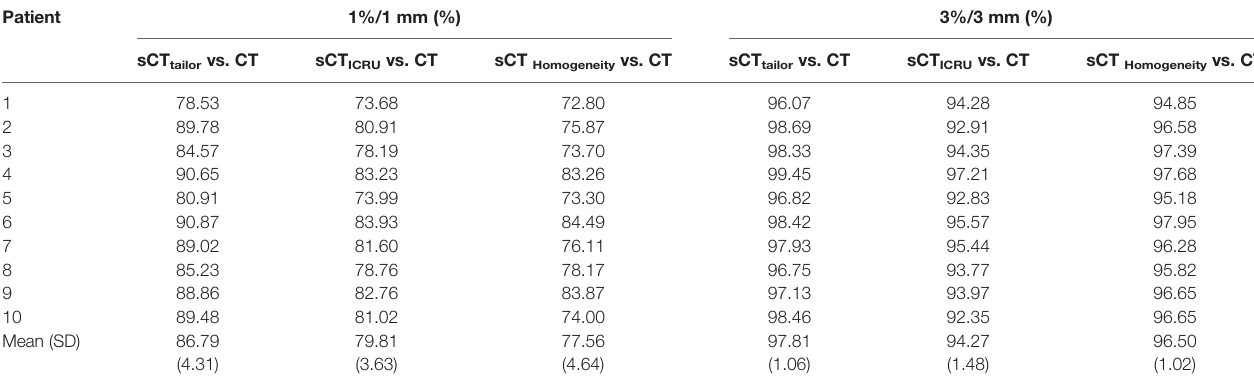
TABLE 3 | Gamma passing rate comparison for 10 patient plans on sCT tailor , sCT ICRU , and sCT Homogeneity (1%/1 mm, 3%/3 mm). Patient 1%/1 mm (%) 3%/3 mm (%) sCT tailor vs. CT sCT ICRU vs. CT sCT Homogeneity vs. CT sCT tailor vs. CT sCT ICRU vs. CT sCT Homogeneity vs.